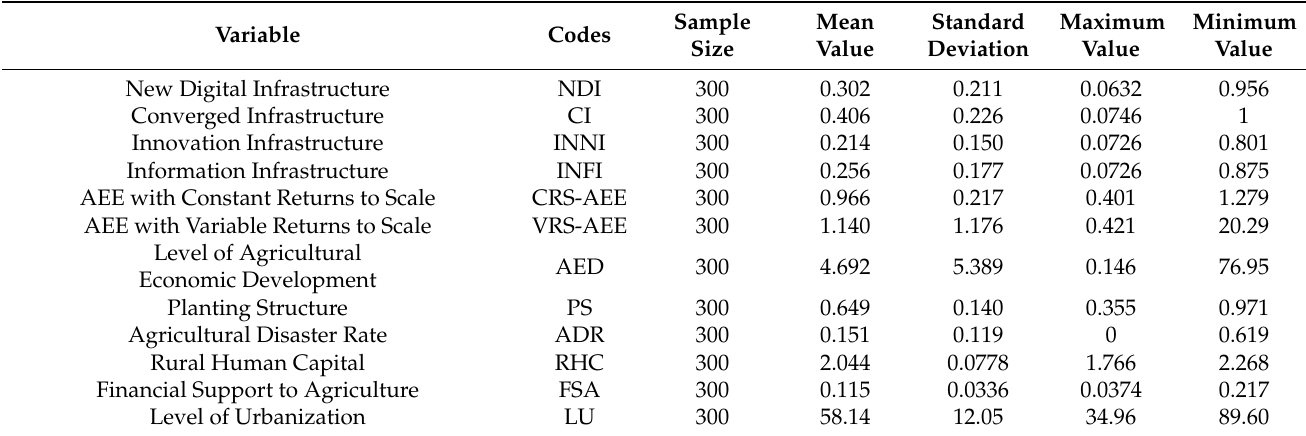
Table 5. Descriptive statistics.